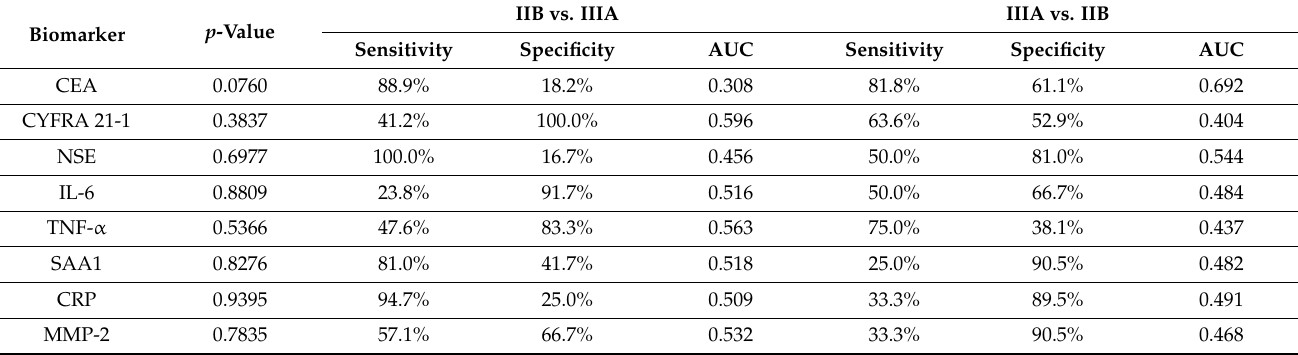
Table 9. The diagnostic efficiency of single biomarkers to distinguish patients with stage IIIA and IIB lung cancer.